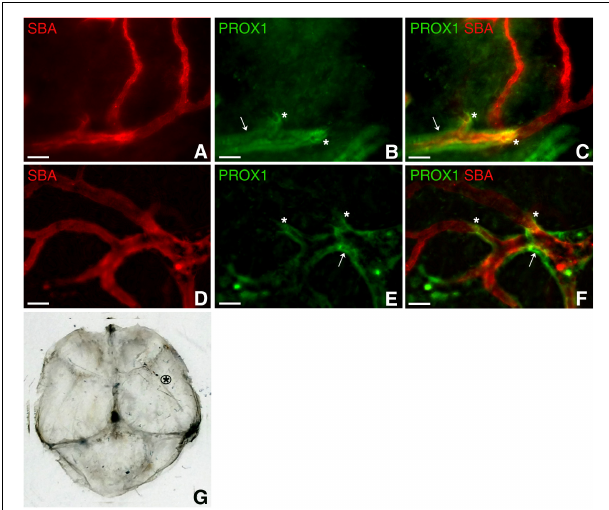
FIGURE 4 | Dural paravascular lymphatic structures. To visualize the blood vasculature, Prox1eGFP mice, in which lymphatic vessels exhibit bright green fluorescence, the hearts were perfused with Kreb’s/albumin solution containing AlexaFluor 594-conjugated SBA lectin. Spinning disk confocal microscopy revealed regions of the blood vasculature (SBA lectin, red) accompanied by dural paravascular PROX1-positive structures (white arrows). After PROX1-positive structures terminate (white asterisks), the blood vessels proceed further through the tissue. In (A,D) SBA lectin blood vessel staining (red). In (B,E) Prox1eGFP lymphatics staining (green). (C,F) Superimposed image. (G) Black asterisk approximates the dura mater area where images were taken. Scale bars in A through F 50 µ m.